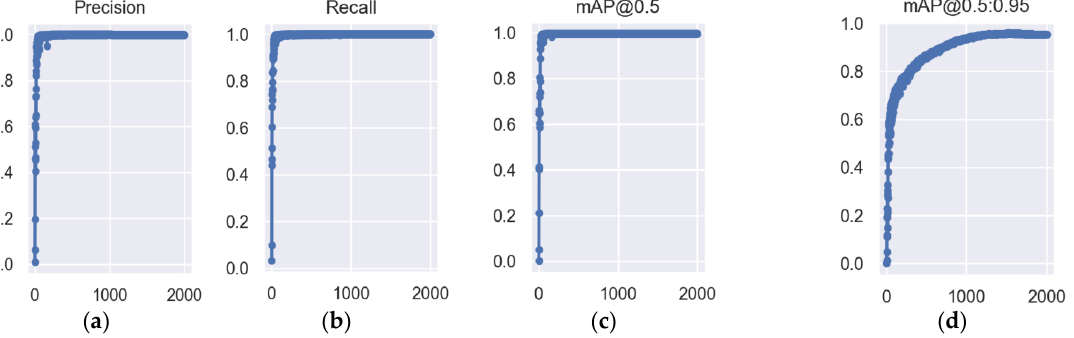
Figure 16. Evaluation results of the improved YOLOv5s-Small-Target model. ( a ) Precision. ( b ) Recall. ( c ) Mean average precison. ( d ) Reconciliated mean average precision.